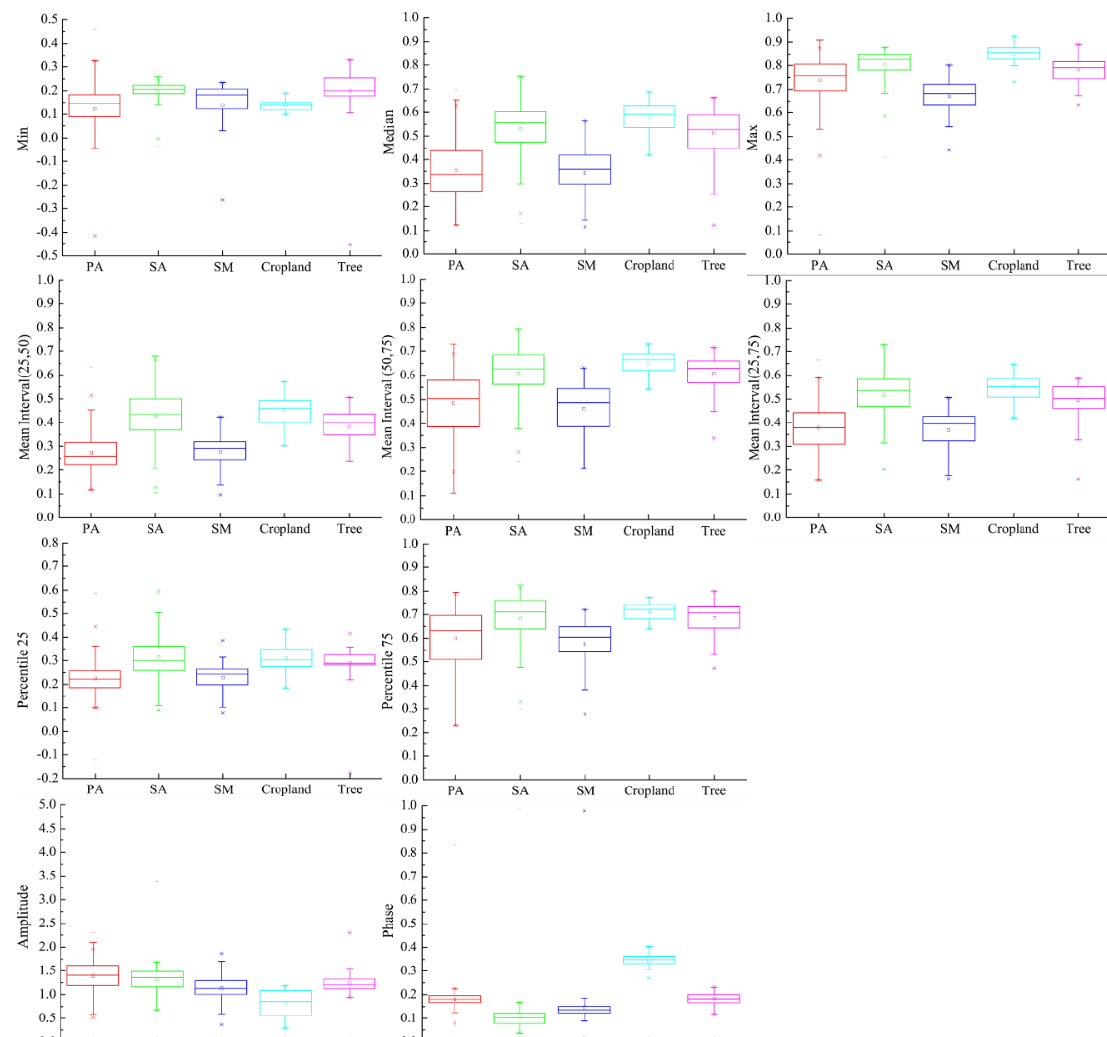
Figure 6. Differences in NDVI of wetland vegetation in various features. The line in the middle of the box represents the median, the dot in the middle of the box represents the mean value, the top, and bottom of the box represent the 25% and 75% percentiles, respectively; the upper and lower lines represent the maximum and minimum values, respectively; and the points that are discrete outside the box are outliers. The red represents P. australis , green represents S. alterniflora , dark blue represents S. mariqueter , light blue represents cropland, and purple represents trees in the figure.